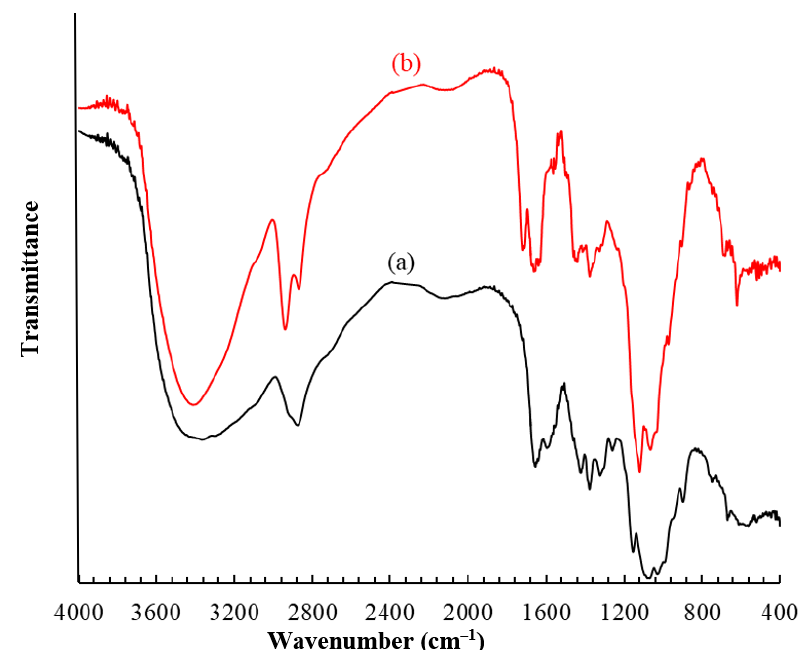
Figure 2. FTIR spectra of pure CS ( a ) and Fe I ӀӀ -CS-GLA ( b ). The spectra were recorded as KBr pellets.